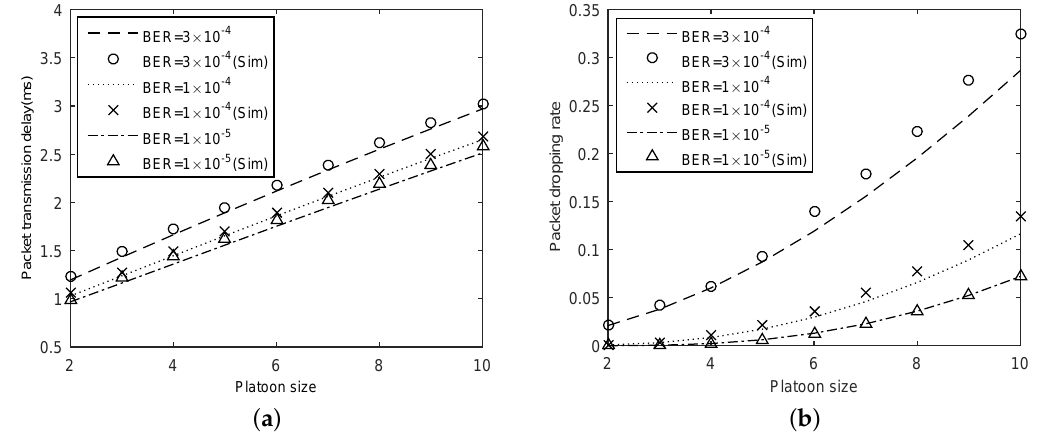
Figure 6. Results for varying p b : ( a ) delay; and ( b ) packet dropping